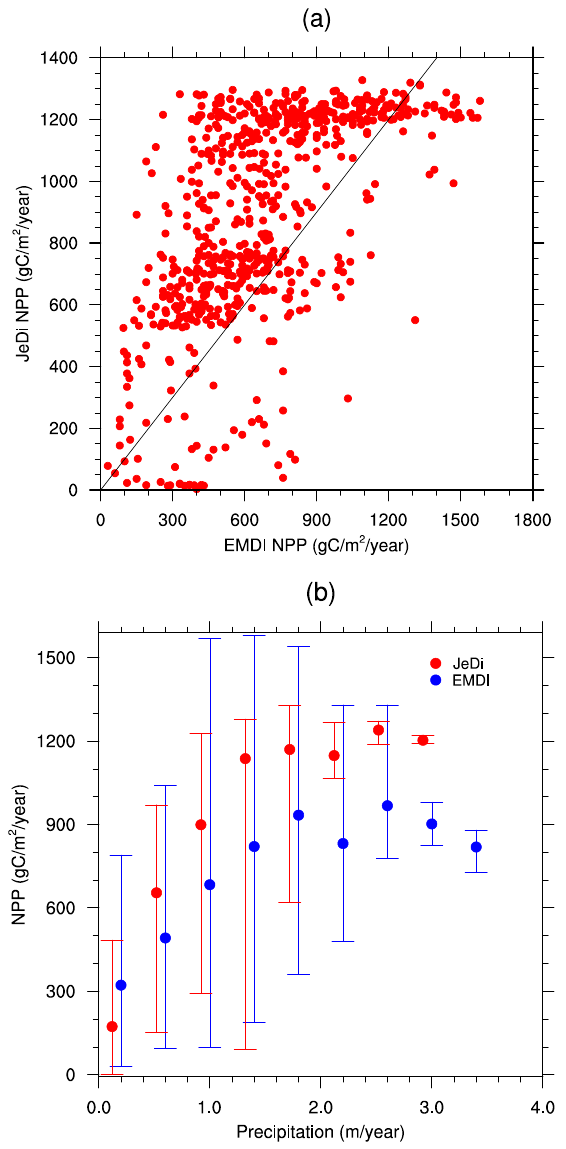
Fig. 4. Comparison of net primary productivity between JeDi- DGVM model output (mean over years 1975–2000) and 933 site observations from the Ecosystem Model–Data Intercomparison (EMDI) initiative class B dataset (Olson et al., 2001). Shown as (a) scatter plot where the red dots represent matched pairs of model grid cells and observation sites and the black line is a 1 : 1 line, and (b) the same but normalized by precipitation (binned into 400 mm yr − 1